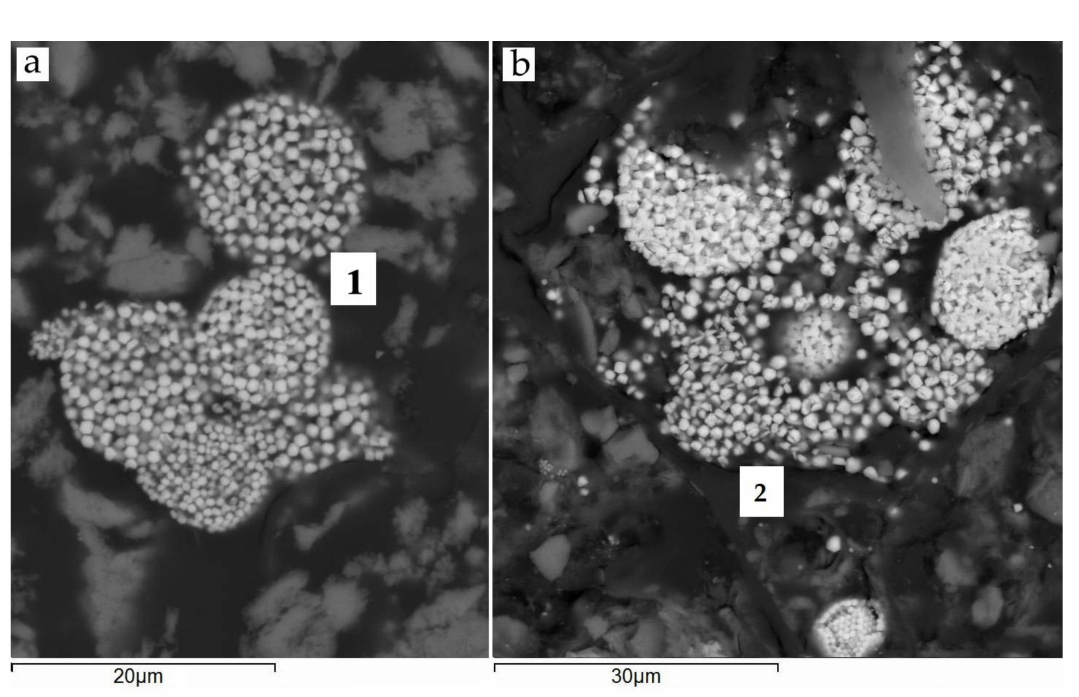
Figure 11. ( a ) Lake Karbalyk (1)—framboidal pyrite from the depth of 0–5 cm of the bottom sediments. ( b ) Lake Kukley (2)—framboidal pyrite and a cluster of pyrite crystals from the depth of 0–5 cm of the bottom